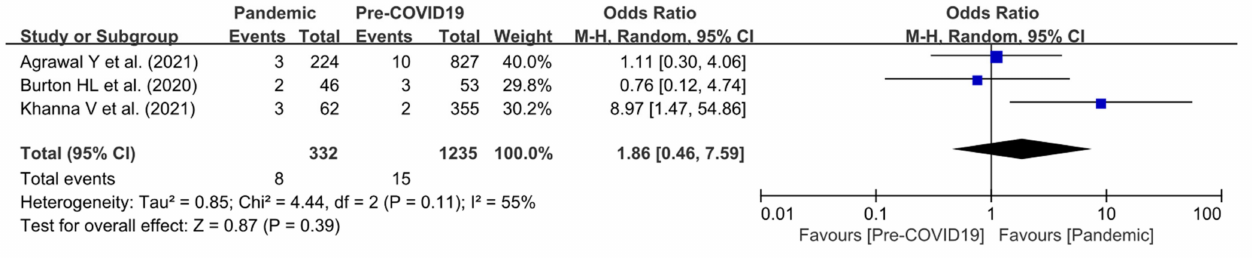
Figure 4. Forest plot comparing the readmission rate within 30 days following hip or knee arthroplasty between the pandemic and pre-pandemic periods